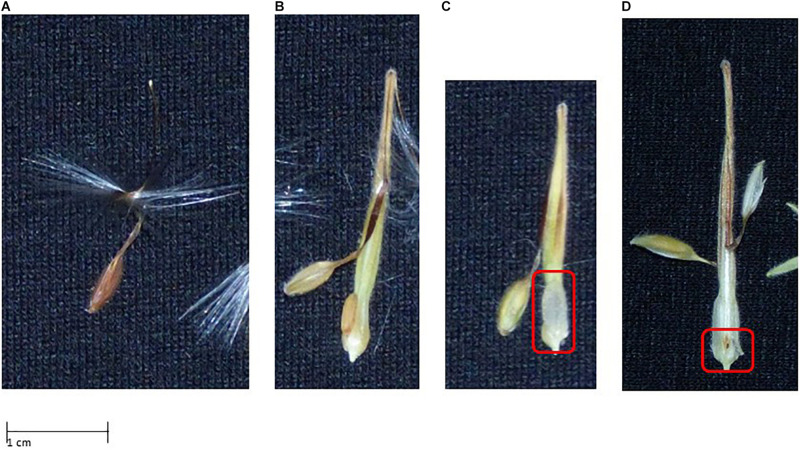
Seed phenotypes displaying signs of Cyto-nuclear incompatibility (see text for further explanation). (A) Normal seed phenotype; (B) bleached seed phenotype; (C) seed containing no or watery endosperm; (D) no embryo development.